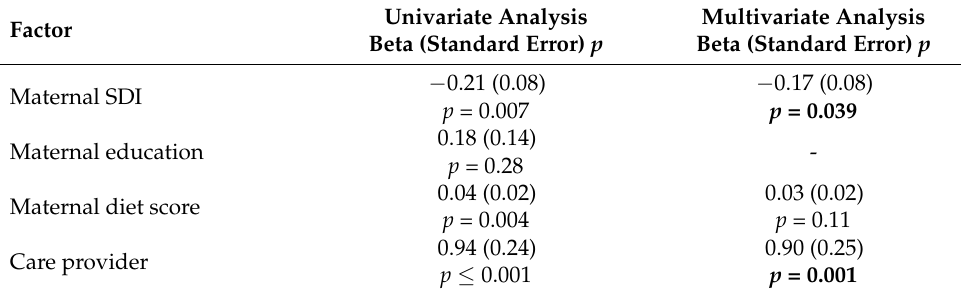
Table 3. Multiple linear regression models for infant diet